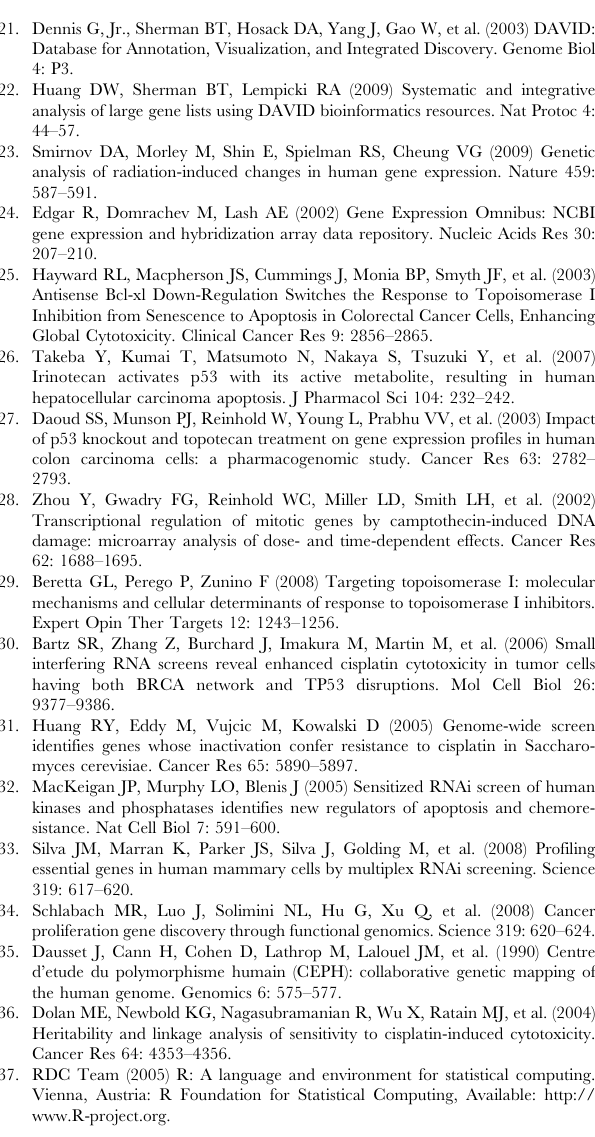
Dataset S4 Boxplots illustrating intra- and inter-family variance in cell viability of each drug and dose